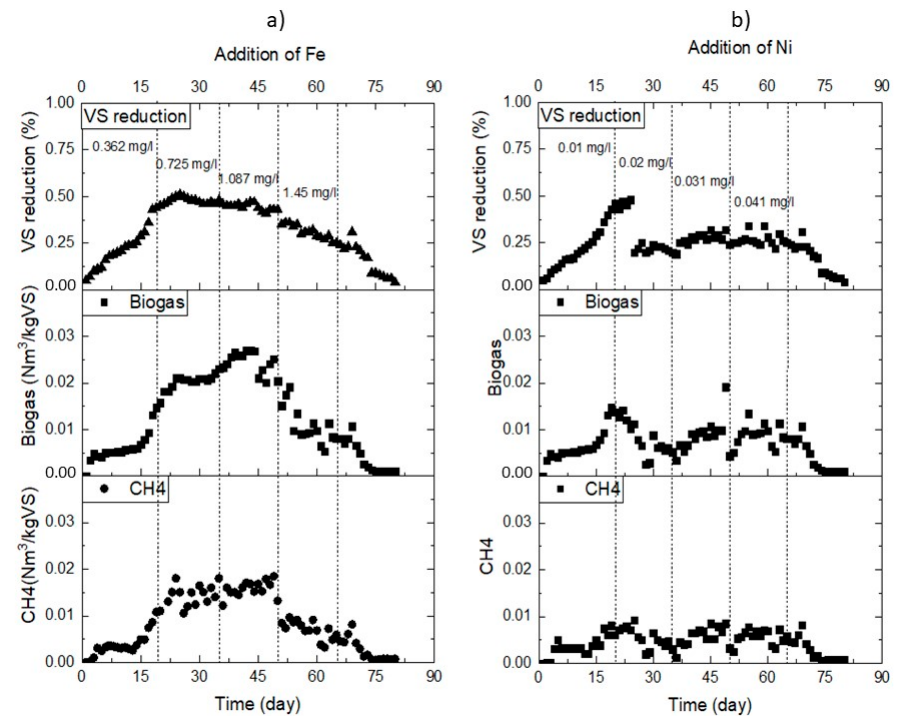
Figure 3. ( a )—Impact of the addition of Fe on anaerobic digestion performance; ( b )—Impact of the addition of Ni on anaerobic digestion performance.